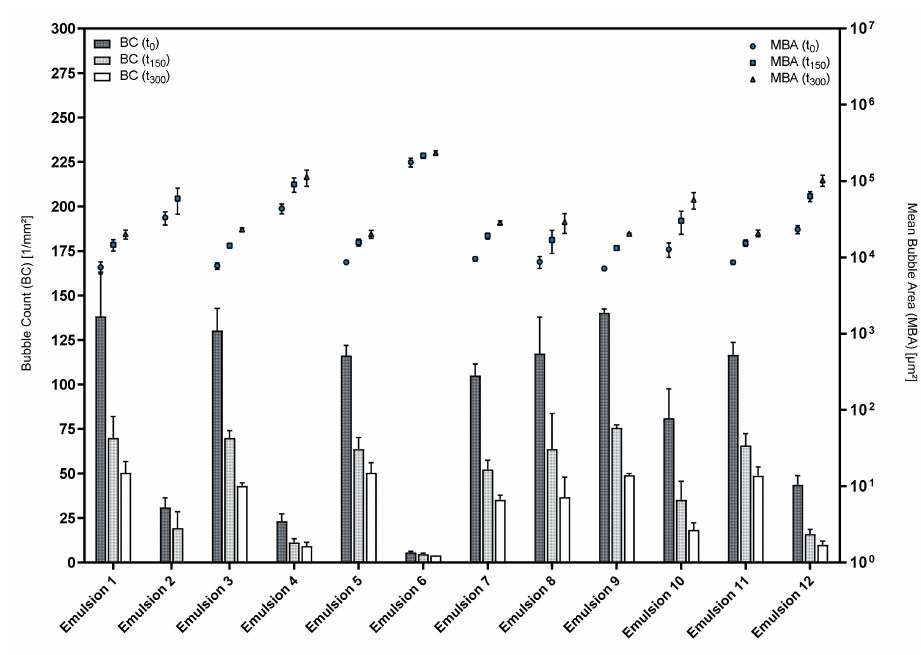
Figure 8. Structures of foamed emulsions over time; mean ± SD, n = 3. Table 5. Comparison of the selected emulsions and the corresponding premixes.